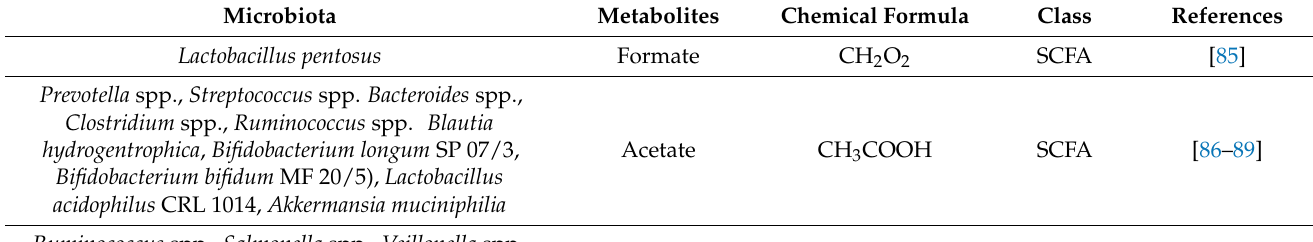
Table 2. Metabolites generate by